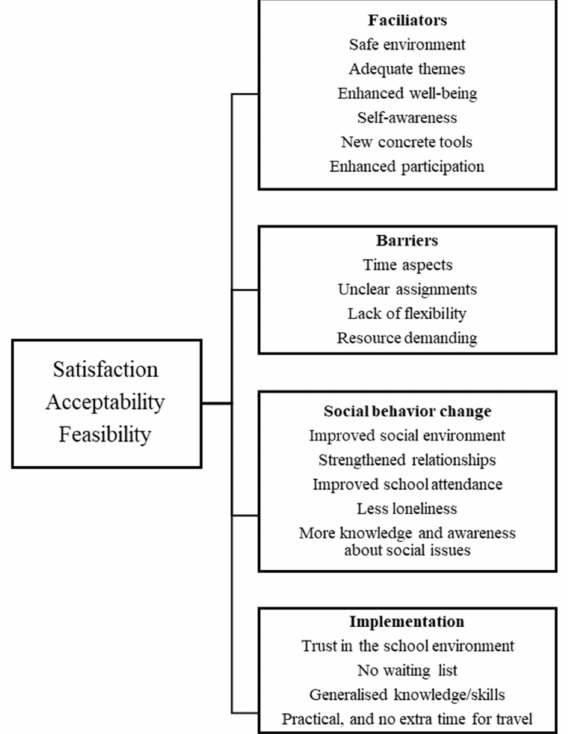
Figure 2. Thematic structure of social validity in social skills group